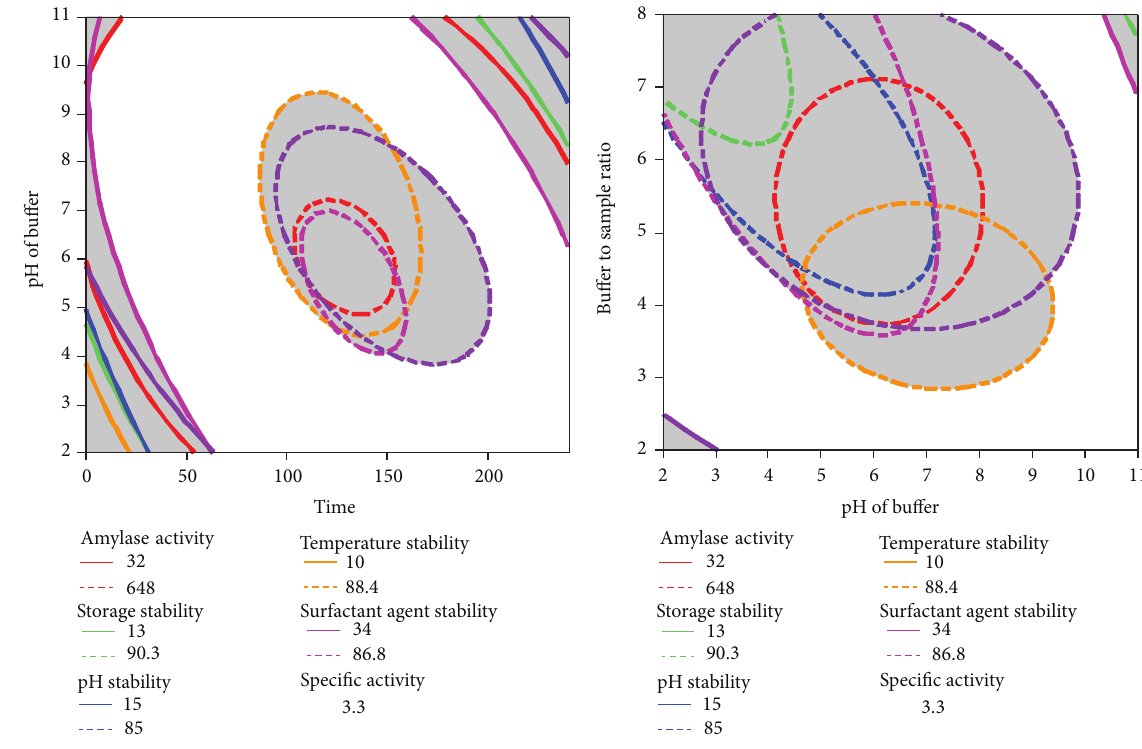
(c) Overlaid contour plot of amylase acti, storage stability, and pH stability. Figure 4: Graphical optimization using overlaid counter plots for showing the optimum area of amylase extraction variables was